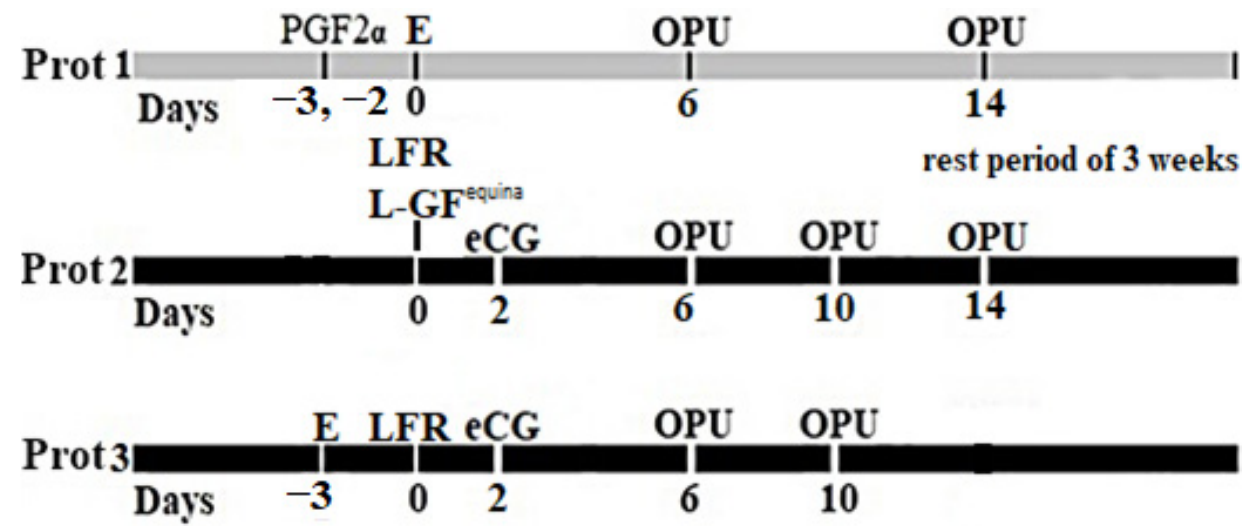
Figure 1. Protocol for OPU in Holstein cows. Protocol 1: estrus detection and OPU session on days 6 and 14 after its detection. Protocol 2: Large follicle (>7 mm) removal (LFR); LGF equina injection on day 0; eCG injection after two days; and OPU sessions on days 6, 10, and 14 after L-GF equina injection. Protocol 3: LFR on day 0; eCG injection after two days; OPU sessions on days 6 and 10 after LFR.